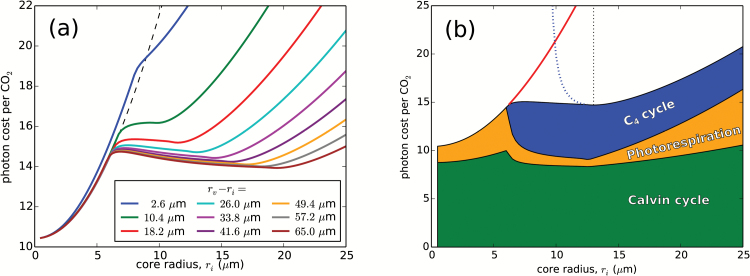
Photon cost variation with core radius. (a) C4-optimized photon cost as a function of the core radius, ri, for a choice of fixed periphery to core distances, rv–ri. The dashed black line shows the C3-only pathway cost at a medium rv–ri of 18 μm; it has negligible dependence on the periphery to core distance. (b) Breakdown of the C4-optimized photon cost into the costs connected with the operation of the Calvin–Benson, the photorespiratory, and the C4 cycle (green, orange, and blue), for the line in (a) with rv–ri=26 μm. The red line shows the C3 pathway photon cost at the same cell geometry. The dotted blue line shows the photon cost when the C4 pump runs with PEPC in abundance (in the finite-PEPC region this cost is not optimal). The vertical dotted line marks the position of the optimal-geometry line (the red line in Fig. 3). Parameters are as in Fig. 2.